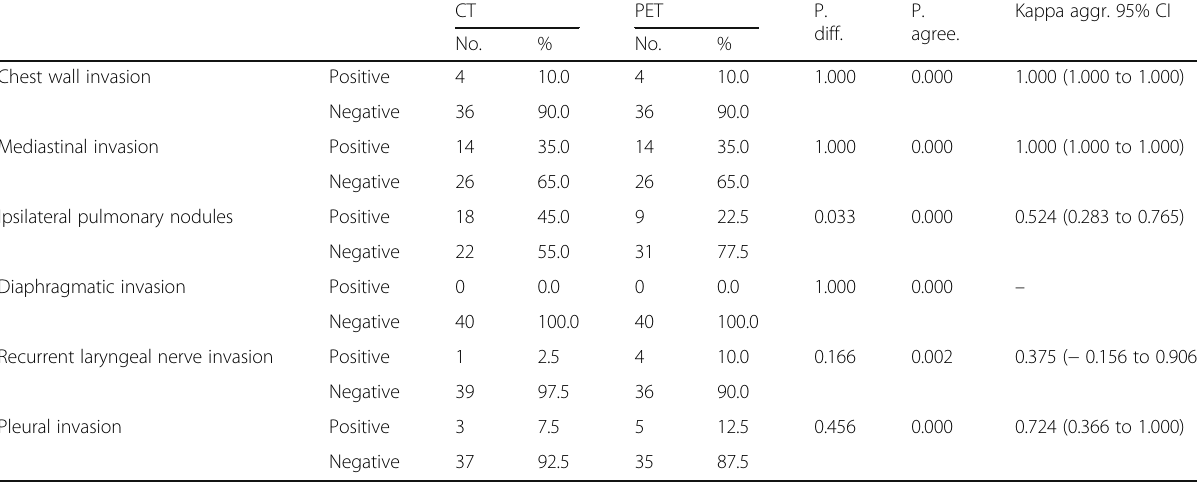
Table 2 Showing local extension of the tumor by CT versus PET-CT